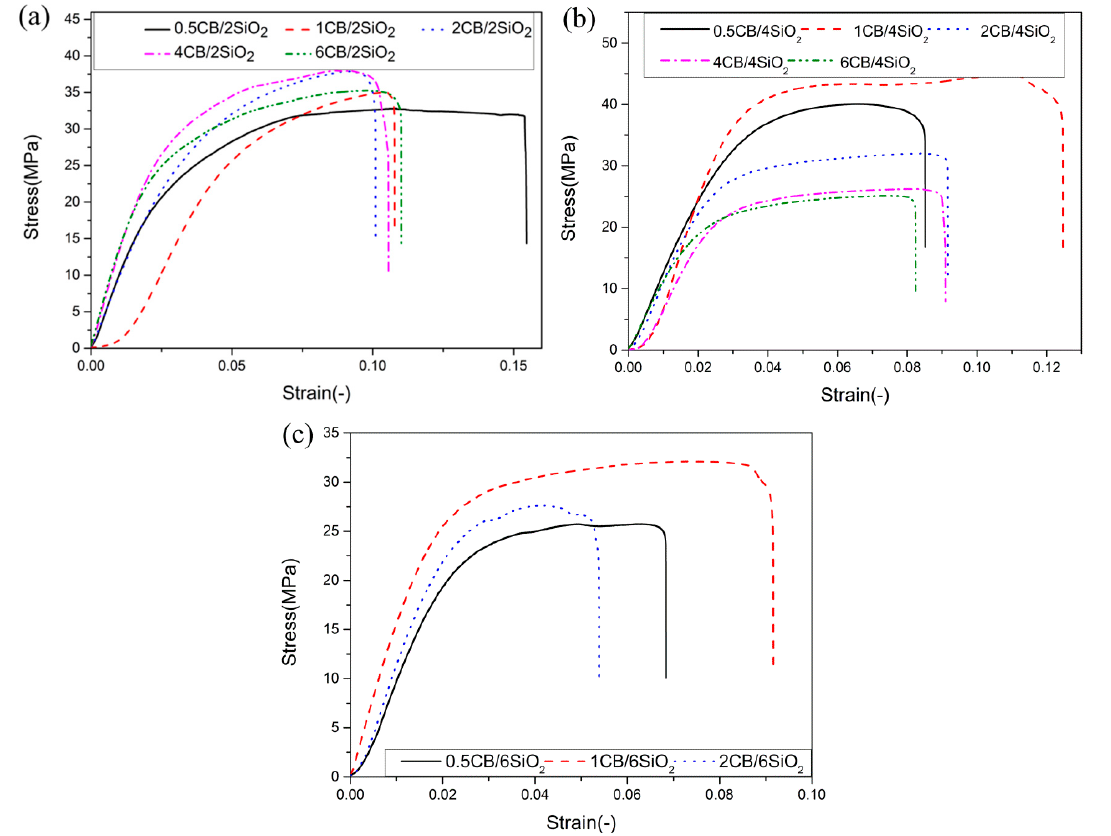
Figure 7. Stress–strain curves of CB/SiO 2 /PVDF composites: ( a ) 2 wt.% SiO 2 ; ( b ) 4 wt.% SiO 2 ; ( c ) 6 wt.% ( c ) 6 wt.% SiO 2 SiO 2 .